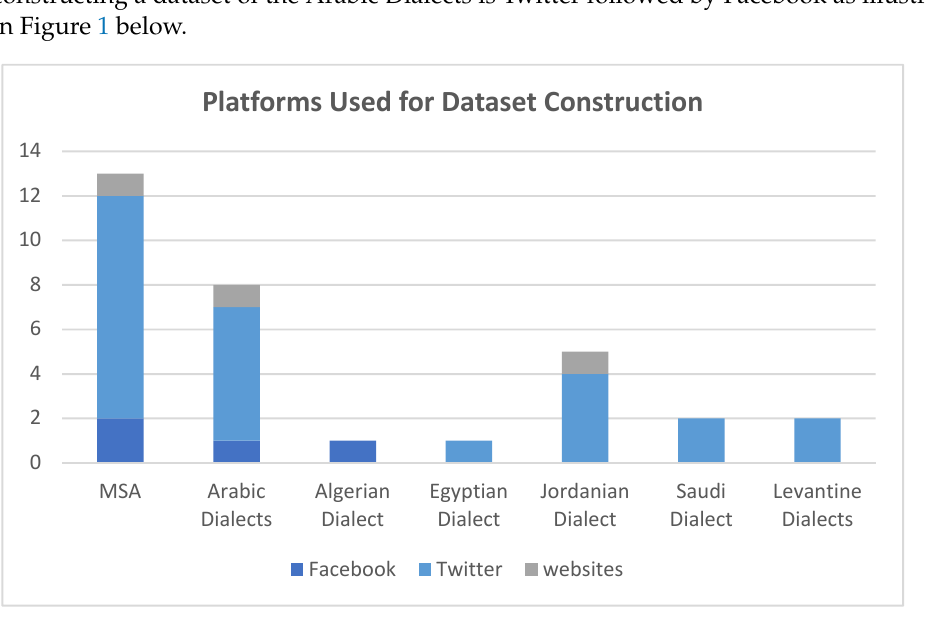
Figure 1. Platforms used for dataset construction.